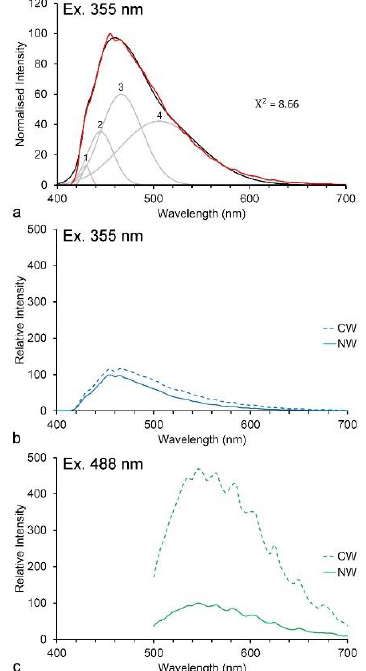
Figure 4. Autofluorescence of lignin in pine wood. ( a ) UV-excited blue fluorescence with λ max at 455–465 nm (excitation at 355 nm, emission at 400–700 nm) showing deconvolution with four log-normal components and a good fit between actual (red) and modeled (black) spectra (X 2 = 8.66, ns). ( b ) Autofluorescence (excitation at 355 nm) of normal (NW) and compression wood (CW) lignin in pine showing a negligible brightness difference. ( c ) Autofluorescence (excitation at 488 nm) of normal and compression wood lignin in pine showing the much brighter green fluorescence reflecting an increased quantum yield in compression wood resulting from blue excitation due to increased p -hydroxy lignin units. The blue-excited spectrum shows some evidence of resonance e ff ects